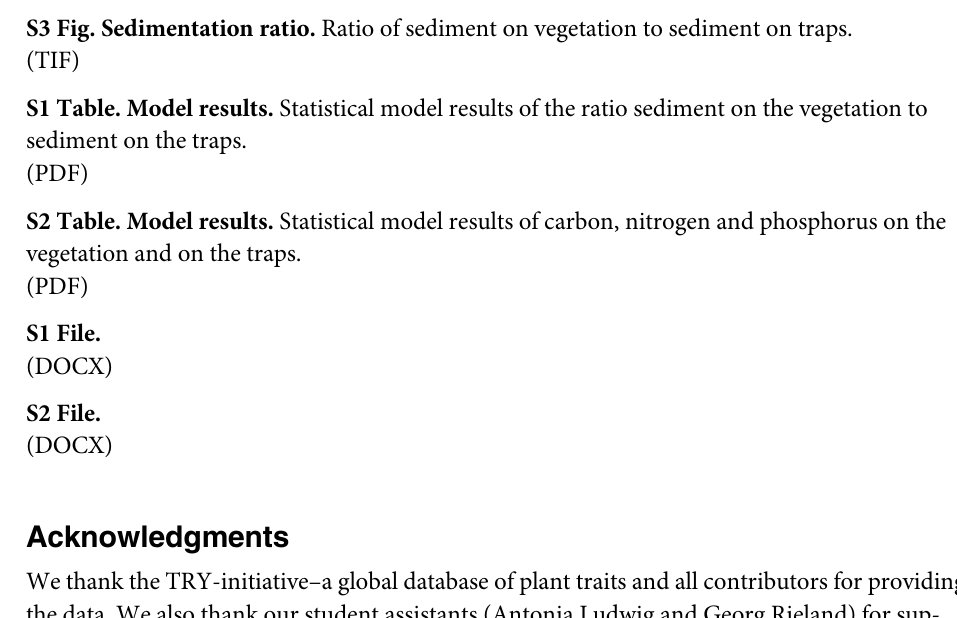
S2 Fig. Sediment traps. Picture of a sediment trap in the field. (TIF) S3 Fig. Sedimentation ratio. Ratio of sediment on vegetation to sediment on traps. (TIF) S1 Table. Model results. Statistical model results of the ratio sediment on the vegetation to sediment on the traps. S2 Table. Model results. Statistical model results of carbon, nitrogen and phosphorus on the vegetation and on the